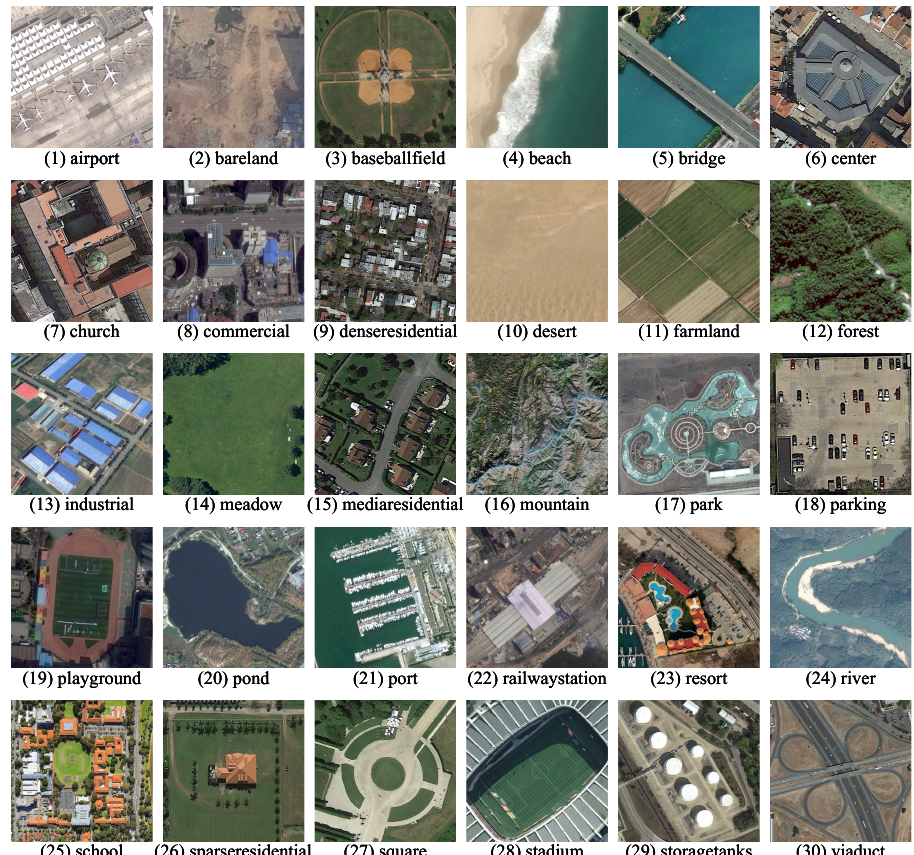
Figure 5. Sample images of the Aerial Image Dataset